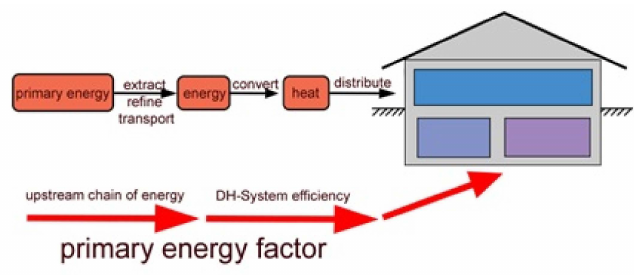
Figure 2. Supply chain of primary energy from renewable sources to